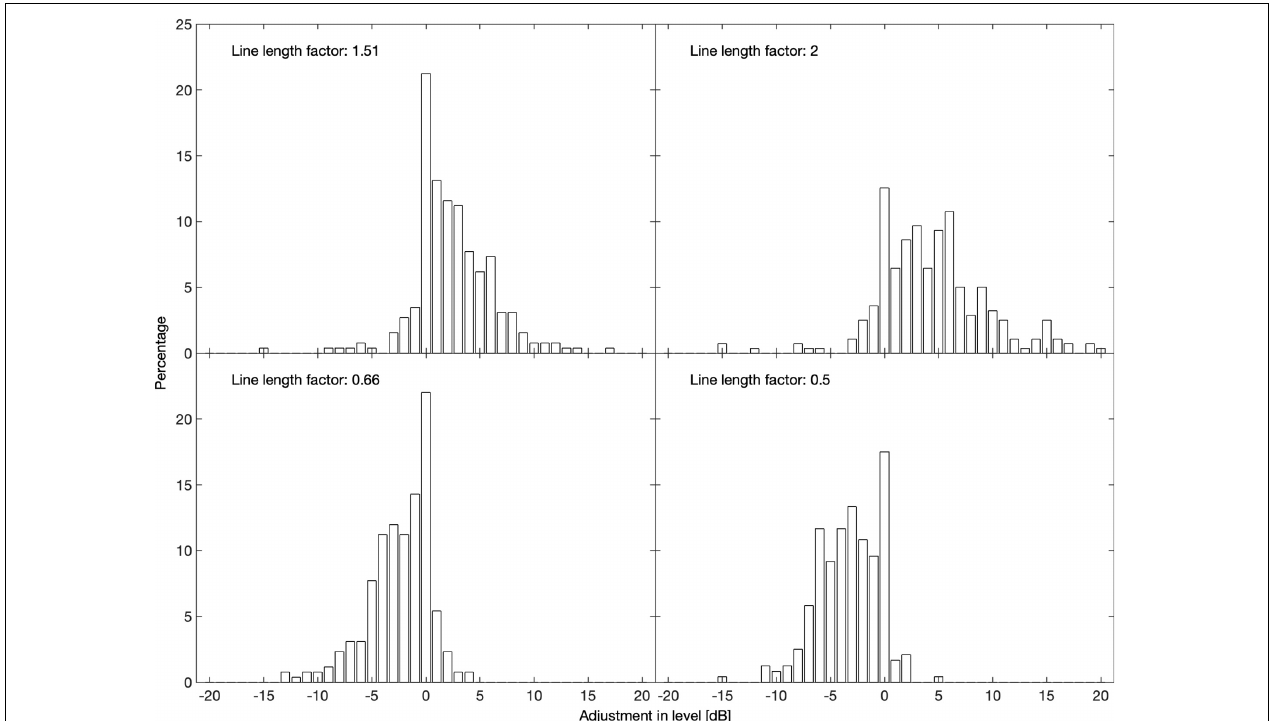
FIGURE 1 | Distributions of level adjustments 5 s after the onset of a manipulation in line length for factors in line length of 1.51 (upper left), 2 (upper right), 0.66 (lower left), and 0.5 (lower right).